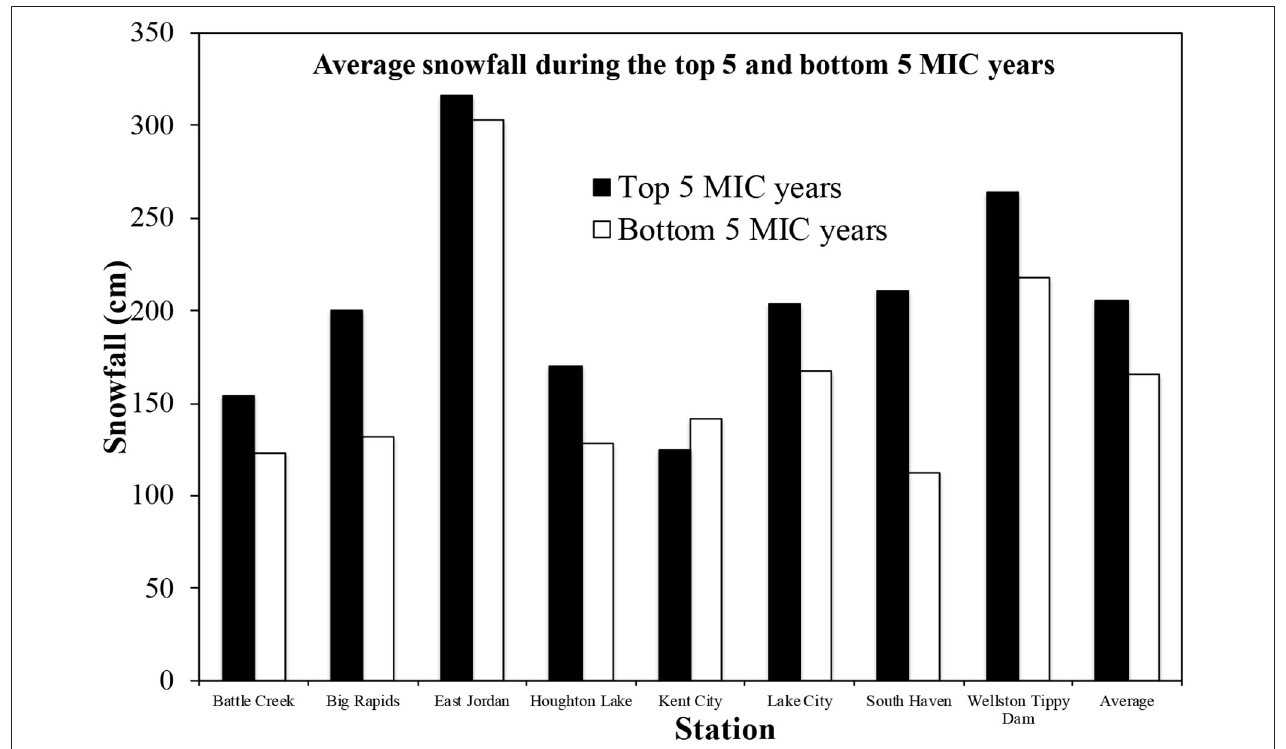
FIGURE 8 | Comparison of average annual total snowfall during the top five and bottom five maximum ice cover (MIC) years at each station and averaged over all